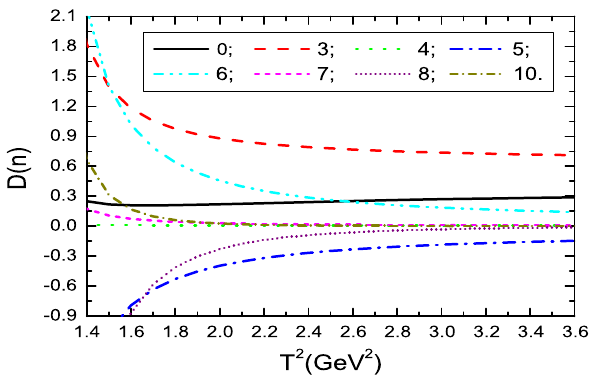
Fig. 2 The contributions of the vacuum condensates of dimension n with variation of the Borel parameter T 2 for the threshold parameter √ s 0 = 4 . 8GeV